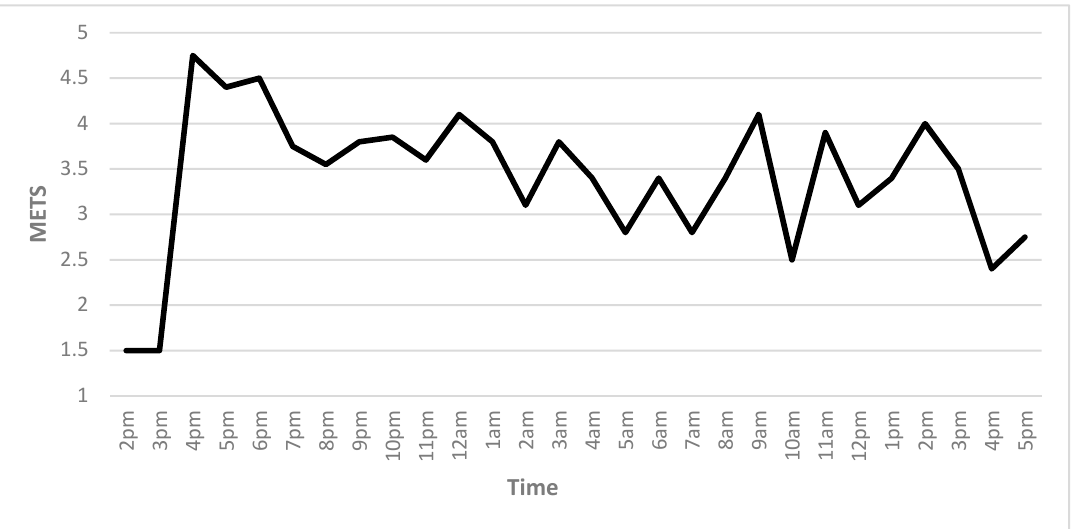
Figure 1. Participant intensity in metabolic equivalents (METS) over time ( < 3 = Low METS; > 6 = High METS).